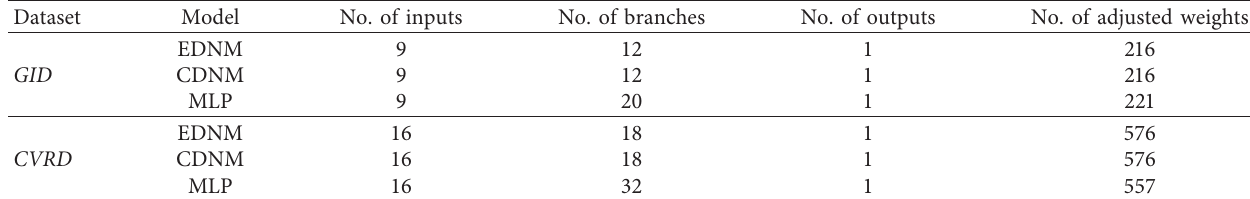
Table 4: Structures of EDNM, CDNM, and MLP for GID and CVRD.